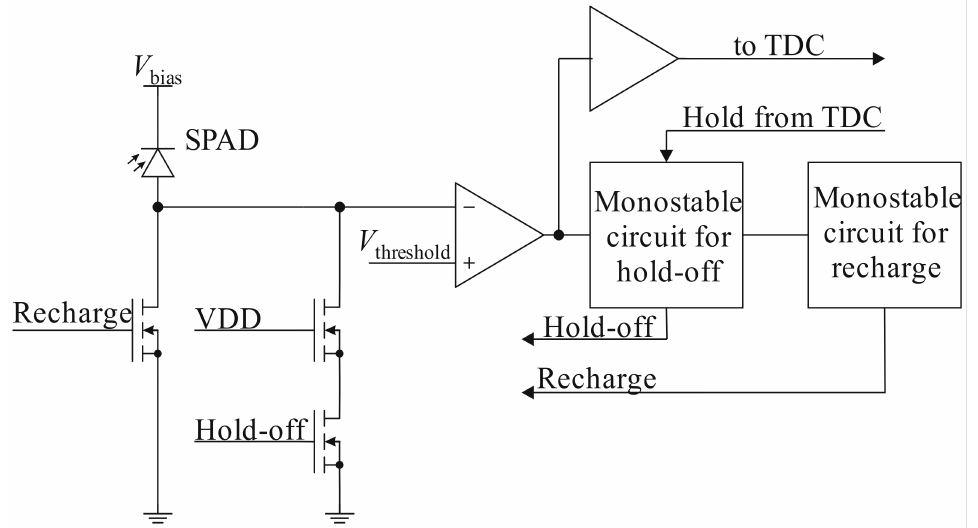
Figure 2. SPAD with a combined active/passive quenching circuit from